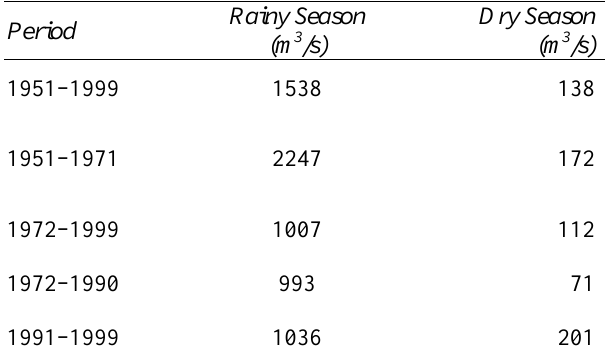
Table 6: Seasonal changes in Senegal River discharge since